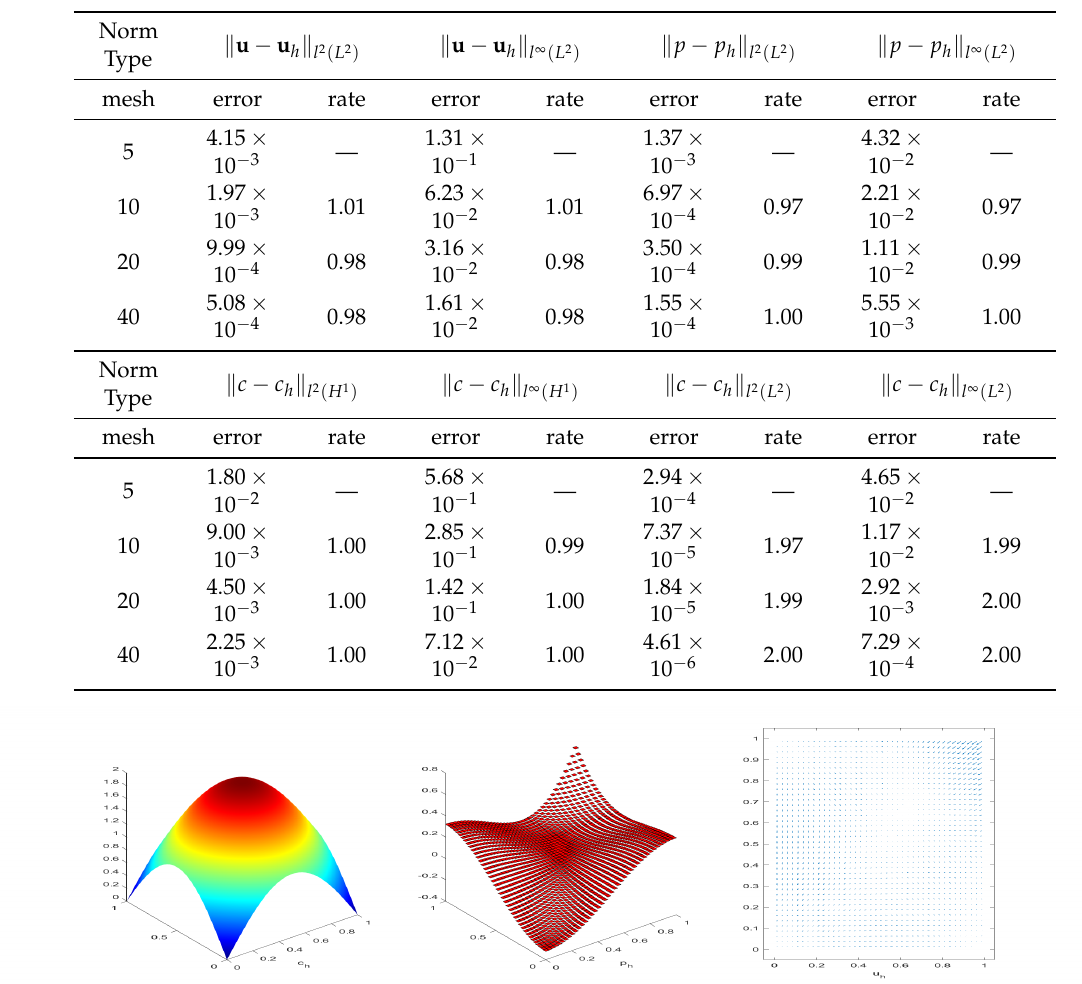
Table 1. Numerical error-and-convergence rates for Example 4.1.